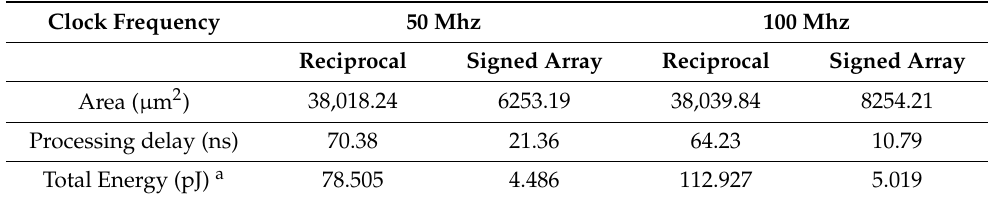
Table 2. Comparison of division calculation using reciprocal and Signed Array.